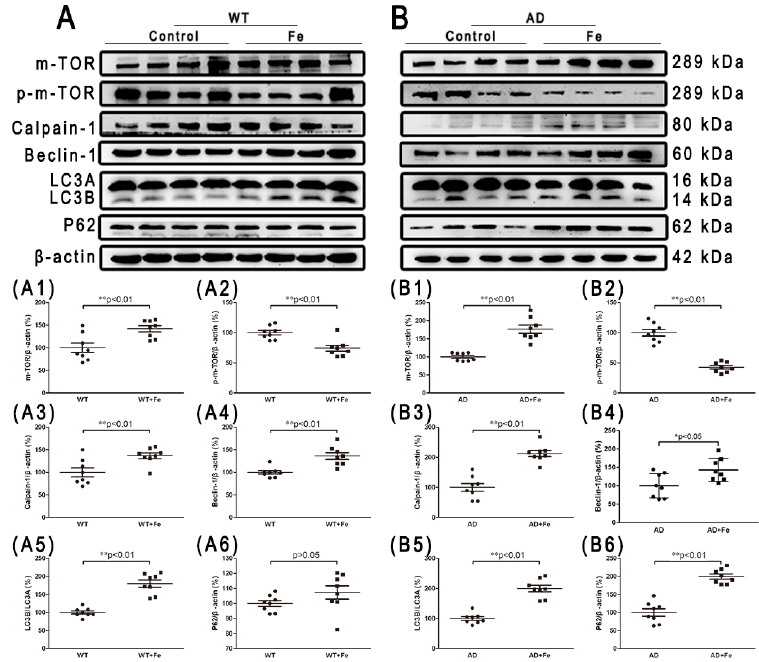
Figure 7. Changes in autophagy-related proteins in the brains of HDI-treated mice. ( A , B ) Western blot analysis of m-TOR, p-m-TOR, calpain 1, beclin 1, LC3 A/B, and P62. ( A1 – A6 , B1 – B6 ) Quantitative analyses of Western blot for m-TOR, p-m-TOR, calpain 1, beclin 1, LC3 A/B, and P62. β -actin was used as an internal control. All results are presented as the mean ± SEM ( n = 8). * p < 0.05, ** p < 0.01.